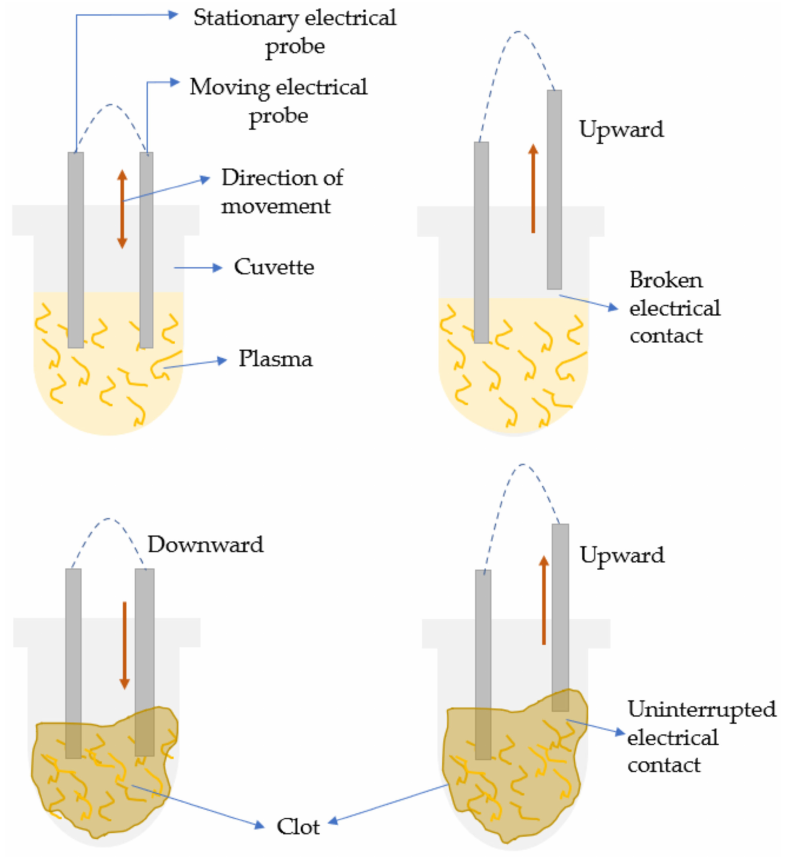
Figure 4. Schematic illustrating the conventional electromechanical form of coagulation detection method using moving electrical probe.